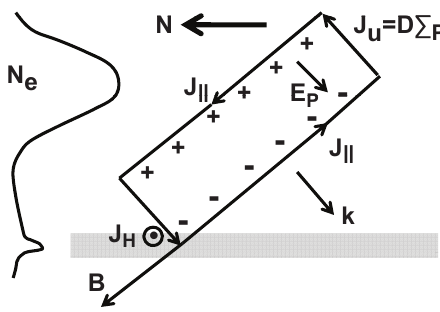
Fig. 6. Schematic showing the geometry of tilted ionization bands projected onto the magnetic meridian plane that can generate polar- ization electric fields large enough to drive two-stream instabilities when the integrated Hall conductivity exceeds the integrated Peder- sen conductivity. Note that the vector k is directed WSW and down.